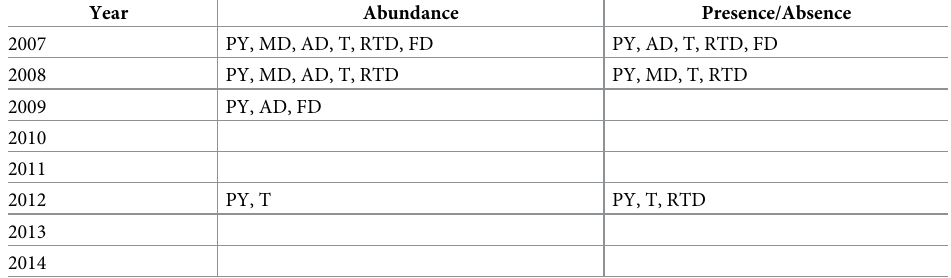
Table 2. SS Thistlegorm dive parameters with significant ( P < 0.05) sequential DistLM test to community struc- ture by year for abundance and presence/absence data. PY as date (expressed as the percentage of year), MD as max- imum depth, AD as depth at most time spent, T as temperature, RTD as dive duration, and FD as hour (expressed as percentage of